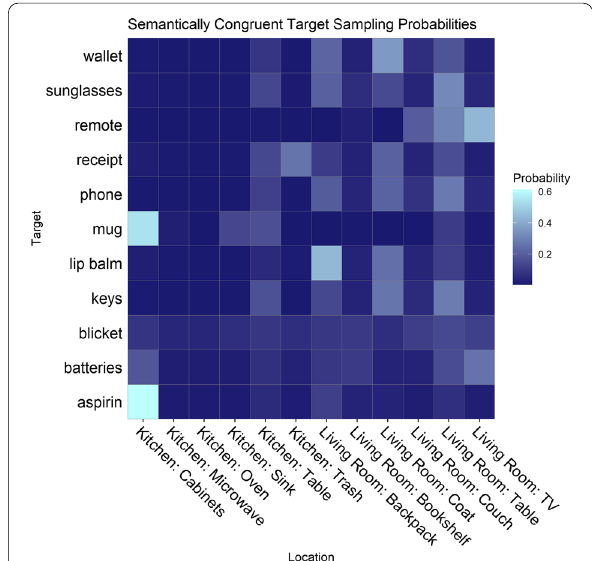
Fig. 3 Heatmap displaying the empirically estimated probability of each target (11 targets, y -axis) occurring in each location (12 locations, x -axis) in the kitchen and living room scenes. The probabilities are congruent with the semantics of the scene